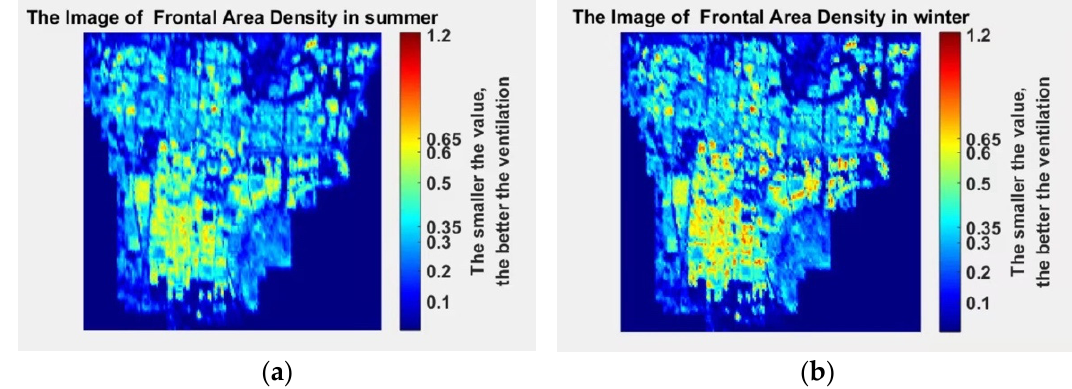
Figure 8. Frontal area density map in the summer and winter: ( a ) summer frontal area density map; ( b ) winter frontal area density map.